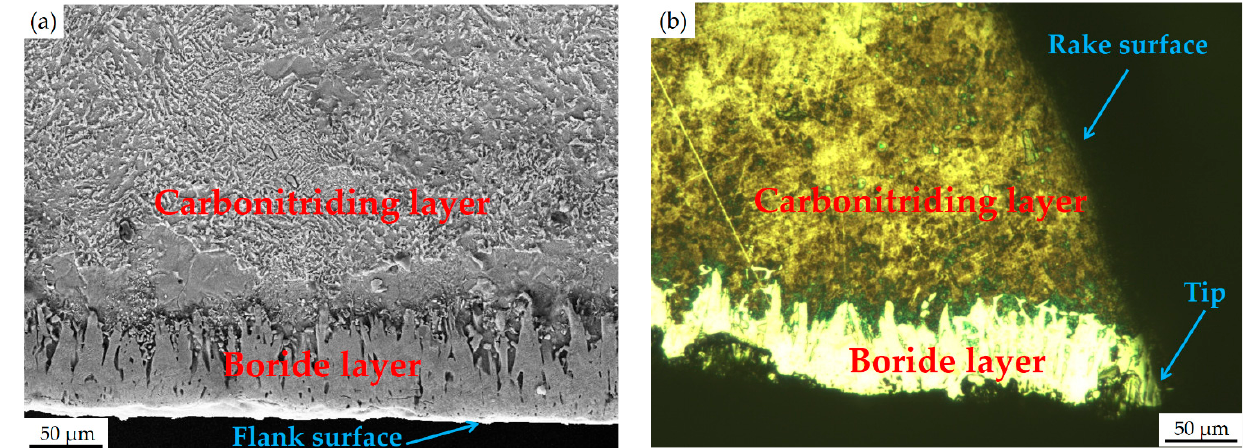
Figure 1. Microstructure morphology of carbon-nitron-boronized layer with rare earth catalysis: ( a ) flank surface of blade; ( b ) rake surface and tip of blade.